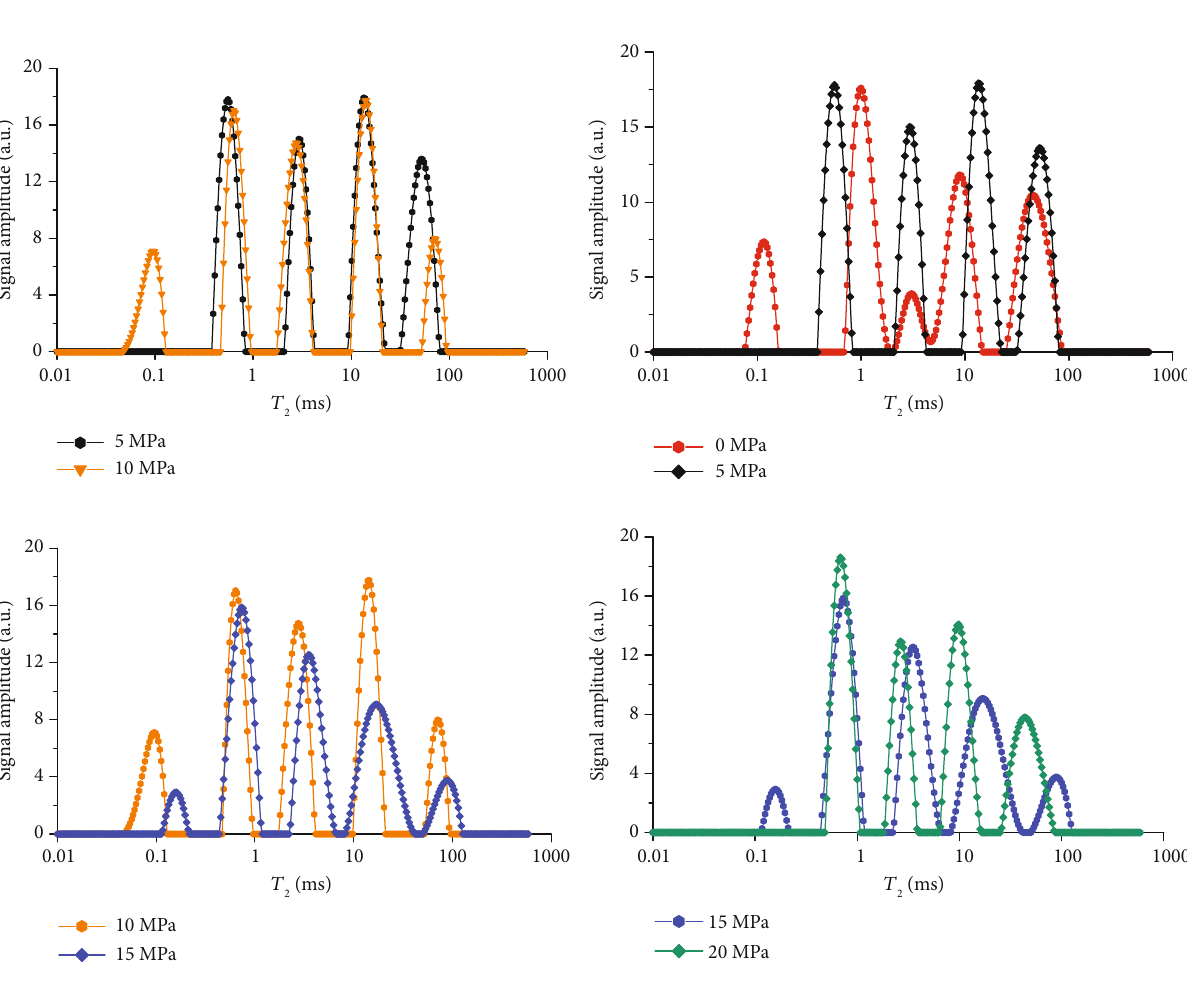
ff erent loads. Figure 3: Peak distribution of sandstone T 2 spectrum under di ff erent loads. Table 1: Peak distribution of sandstone T 2 spectrum under di Spectral peak starting and ending time/ms